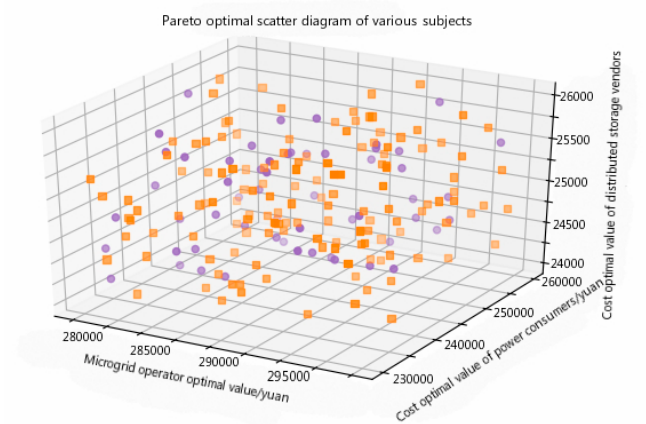
Figure 12. Pareto near global optimum scatter diagram of various subjects.